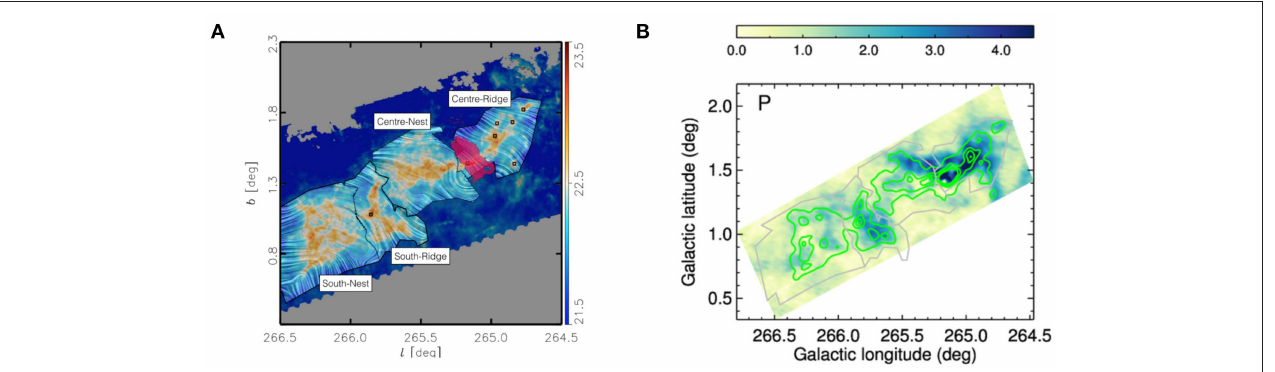
FIGURE 4 | Polarization observations of the Vela C cloud from the BLASTPol telescope. (A) Magnetic field orientation (texture) inferred from the BLASTPol 500 µ m data overlaid on a Herschel -derived column density ( N H ) map—Soler et al. (2017), reproduced with permission © ESO. Four sub-region are labeled, while the shaded pink region indicates where the dust is heated by a compact H II region. (B) Map of polarized intensity with contours of total intensity (green) overlaid (from Figure 3 of Fissel et al., 2016 © AAS. Reproduced with